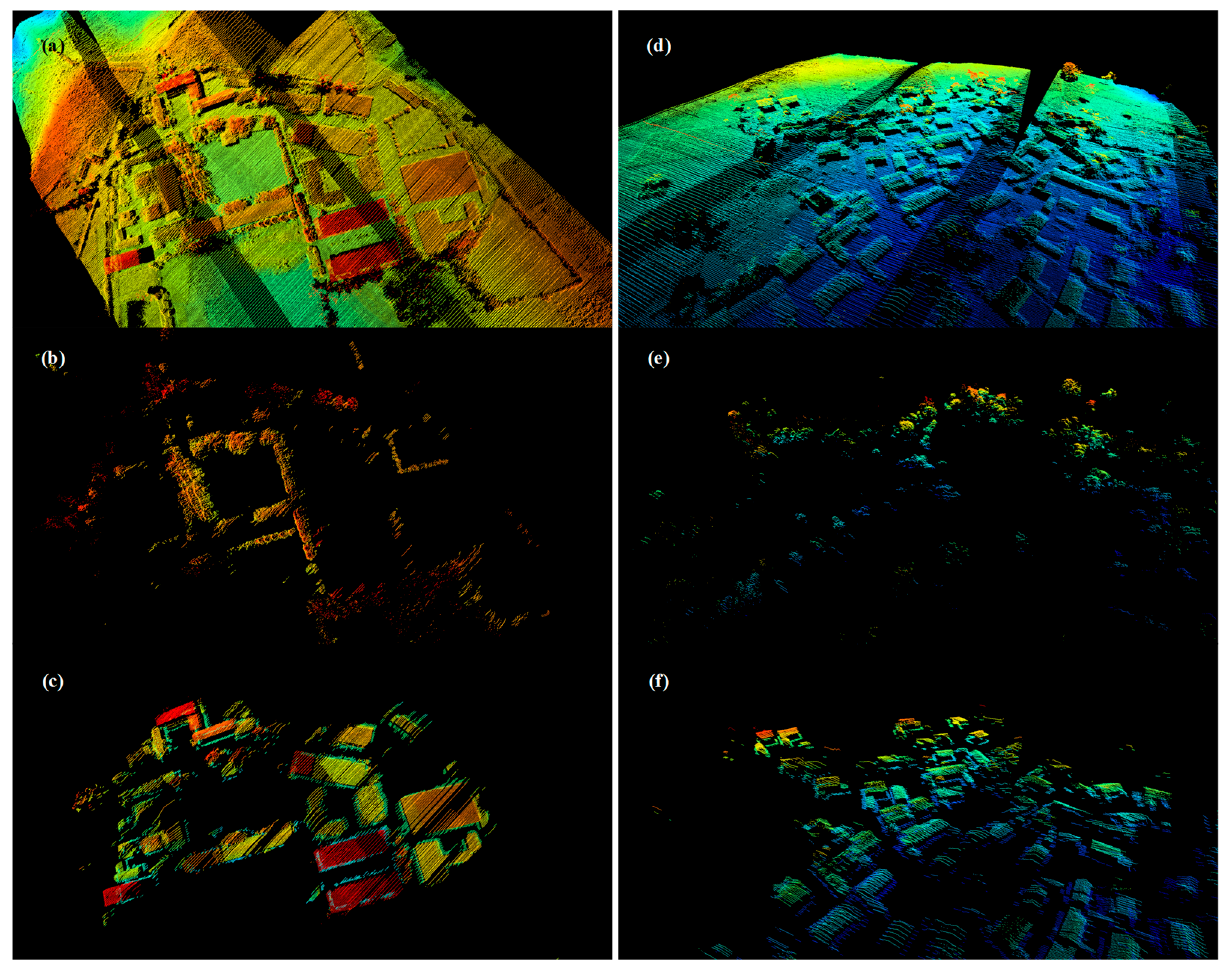
Figure 9. Target extraction results of ASTIL fast-processing system. ( b ) and ( c ) are the tree extraction result and the building extraction result for the area ( a ), respectively. ( e ) and ( f ) are the tree extraction result and the building extraction result for the area ( d ), respectively.